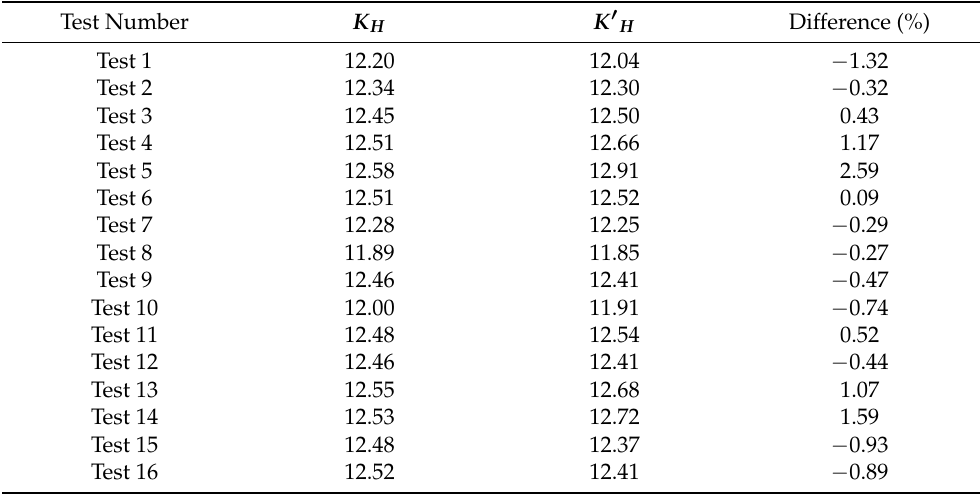
Table 6. Comparison between the horizontal stiffness coefficients from expressions and finite ele- ment analyses.